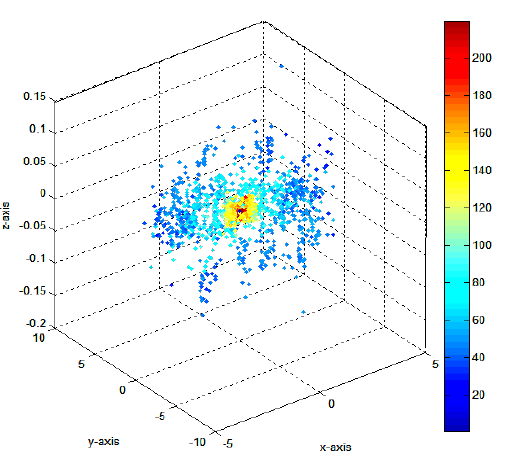
Fig.4: Velocity distributions in x-y plane of the spiral hot disk model after 626.28 million